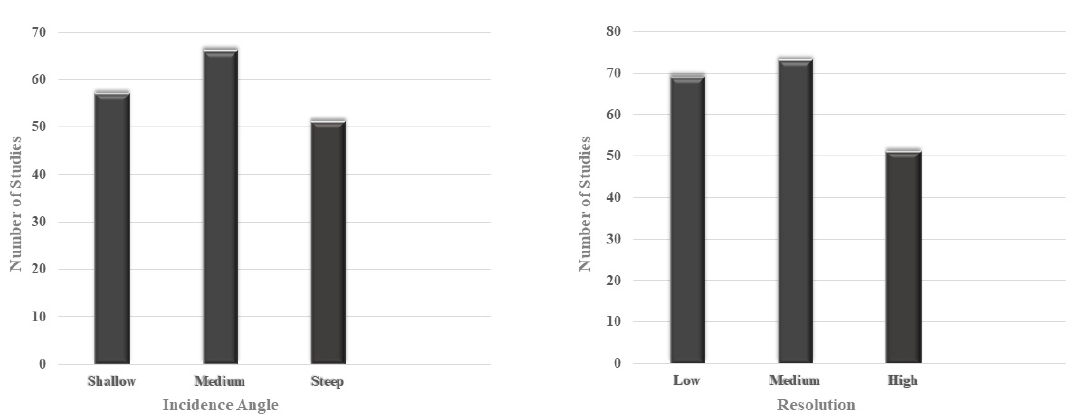
Figure 7. Number of studies on SAR and wetland monitoring versus incidence angle and resolution. Figure 8 indicates the launch and end mission dates of the major SAR sensors from 1990 until present. The steps for the years are two and the odd years are in the middle.